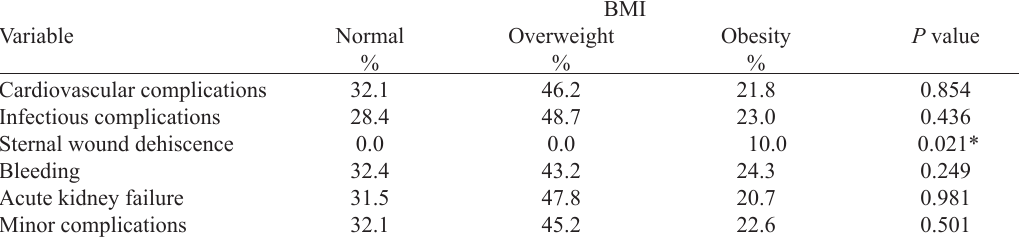
Table 4. Association between BMI and postoperative complications from CABG and/or valve replacement (univariate analysis).